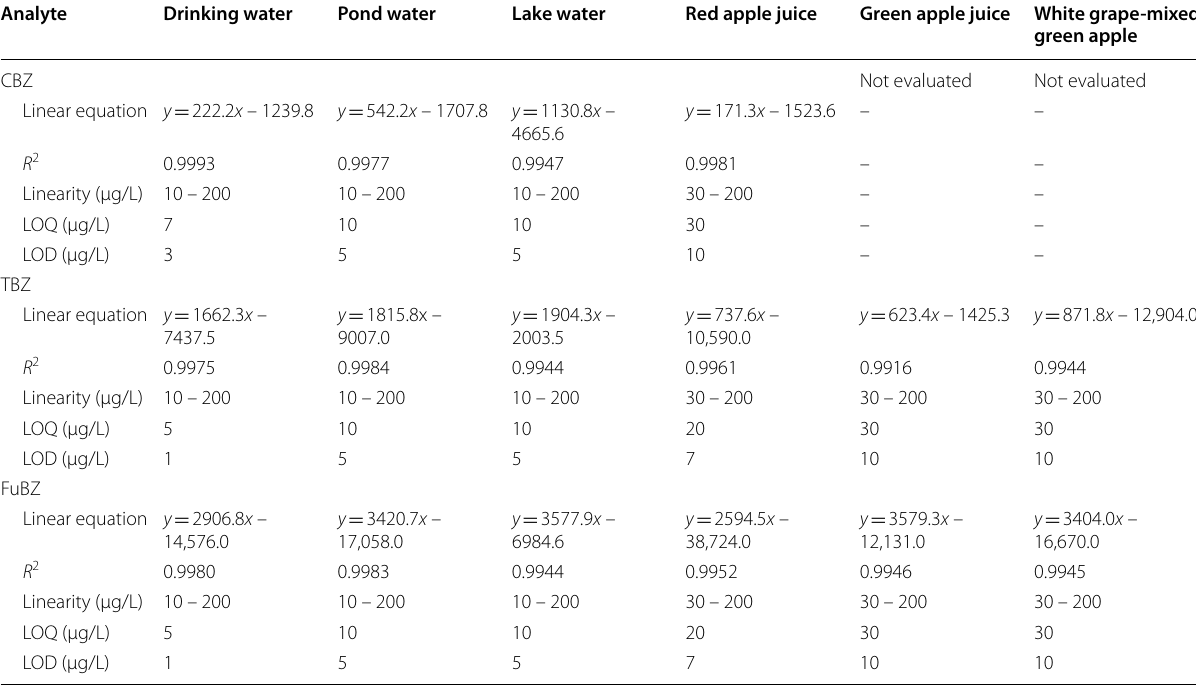
Table 2 Analytical characteristic of the method for the analysis of target fungicides in water and apple juice samples